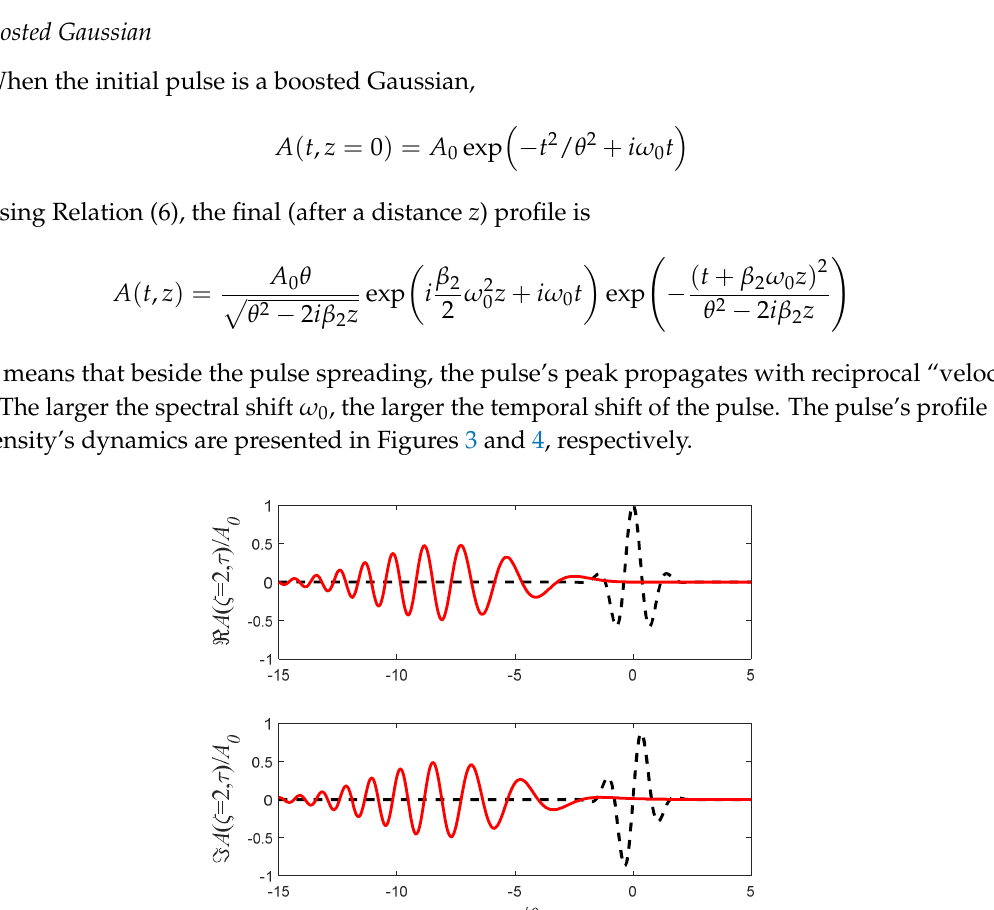
  2 , ztA (Equation (14)) as a function of /  z . 2